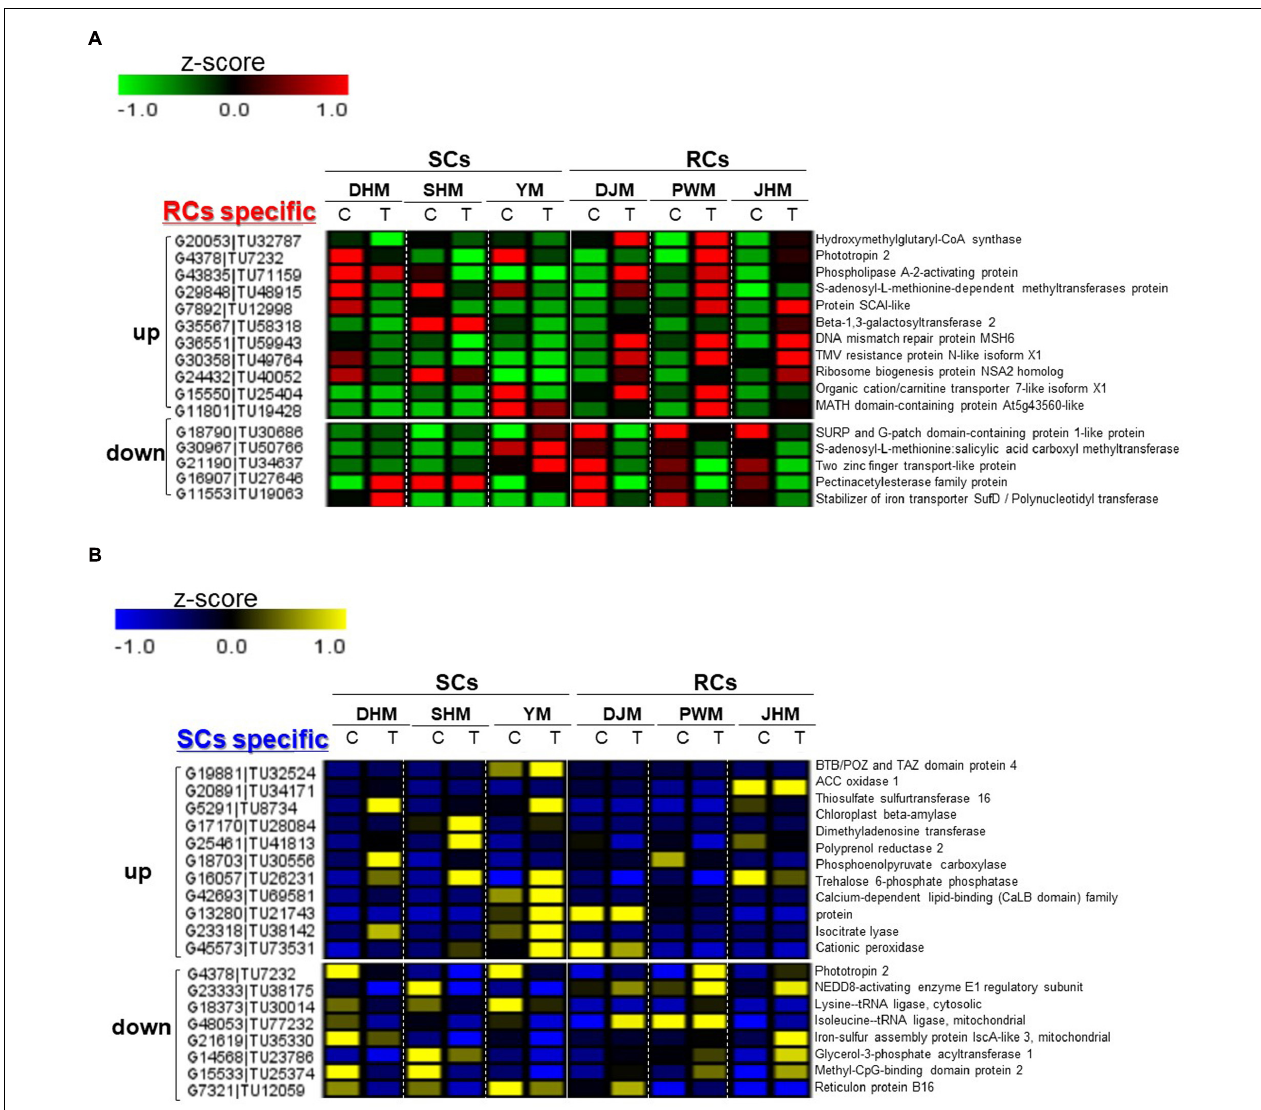
FIGURE 4 | Comparison of the expression levels of induced defense response-related specific candidate genes in six sweetpotato cultivars under RKN-infected and control conditions. DEGs include (A) RC-specific and (B) SC-specific up- and downregulated genes. DHM, Dahomi; DJM, Danjami; PWM, Pungwonmi; SHM, Shinhwangmi; JHM, Juhwangmi; YM, Yulmi; RCs, resistant cultivars; SCs, sensitive cultivars; C, control; T, treatment. The heatmap was constructed using Multi Experiment Viewer